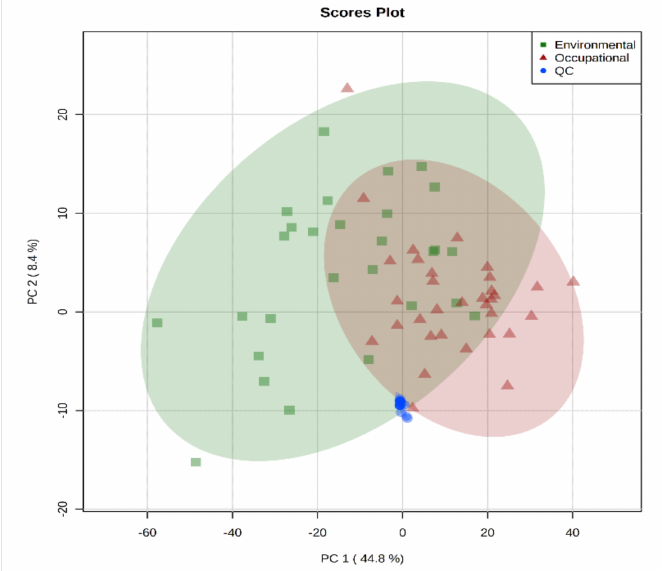
Figure 2. Principal component analysis-PCA (PC 1 × PC 2) of urine samples from workers exposed and occupationally to benzene, with provision for environmental quality control samples (QCs).